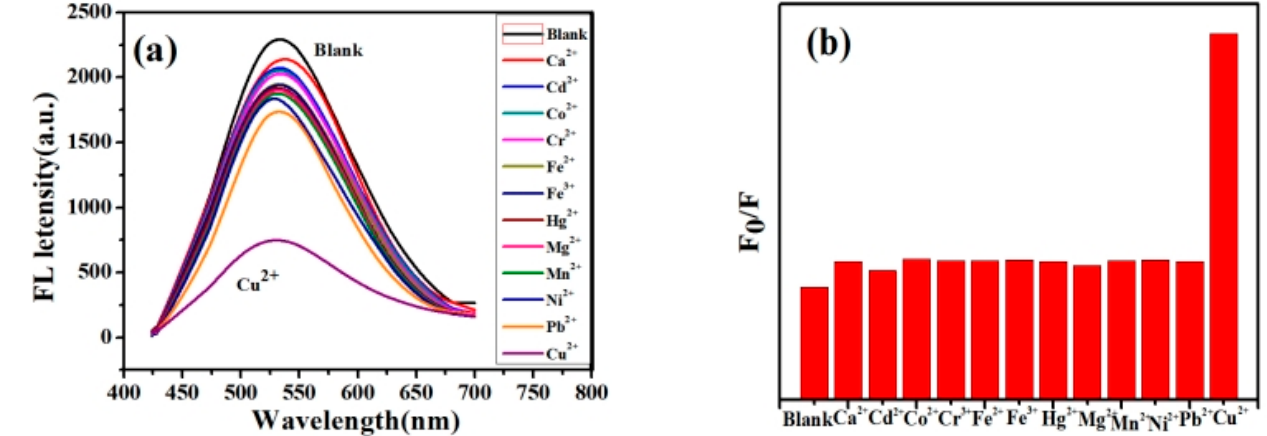
Figure 3. ( a ) Fluorescence spectra of the different heavy metal ions added; ( b ) relative fluorescence intensity of the di ff erent heavy metal ions added.